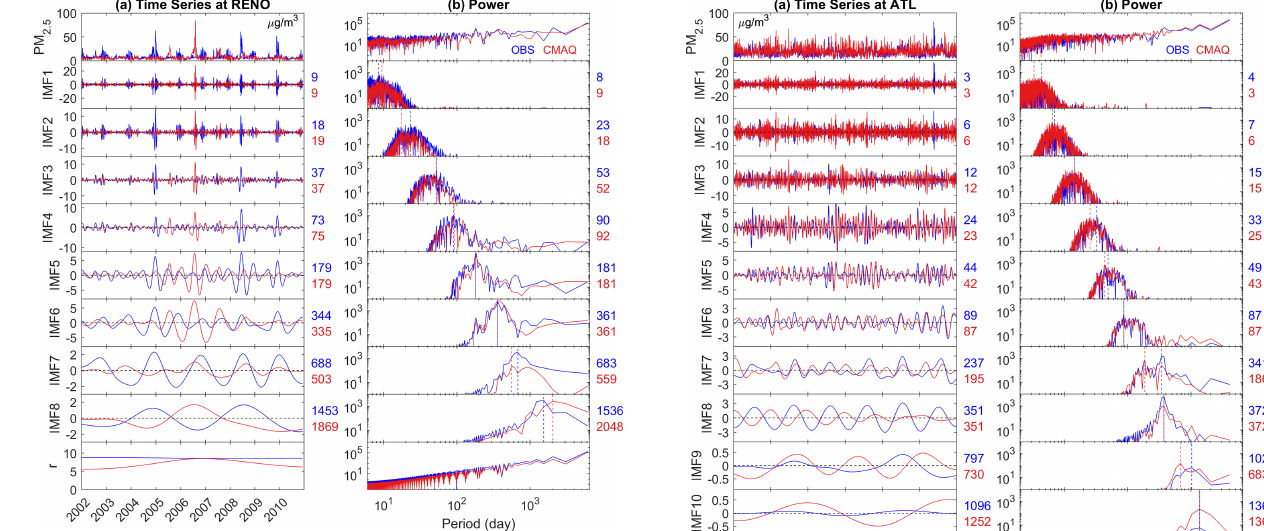
Figure 4. Same as Fig. 2 but for the RENO site with 8 IMFs.